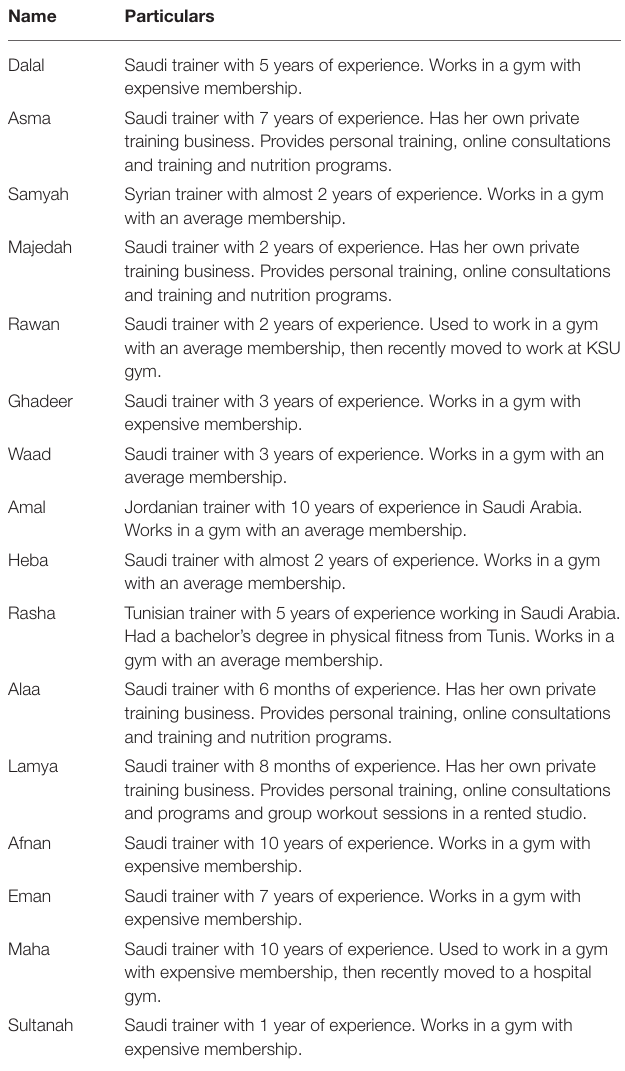
TABLE 2 | Brief background on female trainers who were interviewed. TABLE 3 | Median and interquartile ranges for participants who reported engaging in any physical